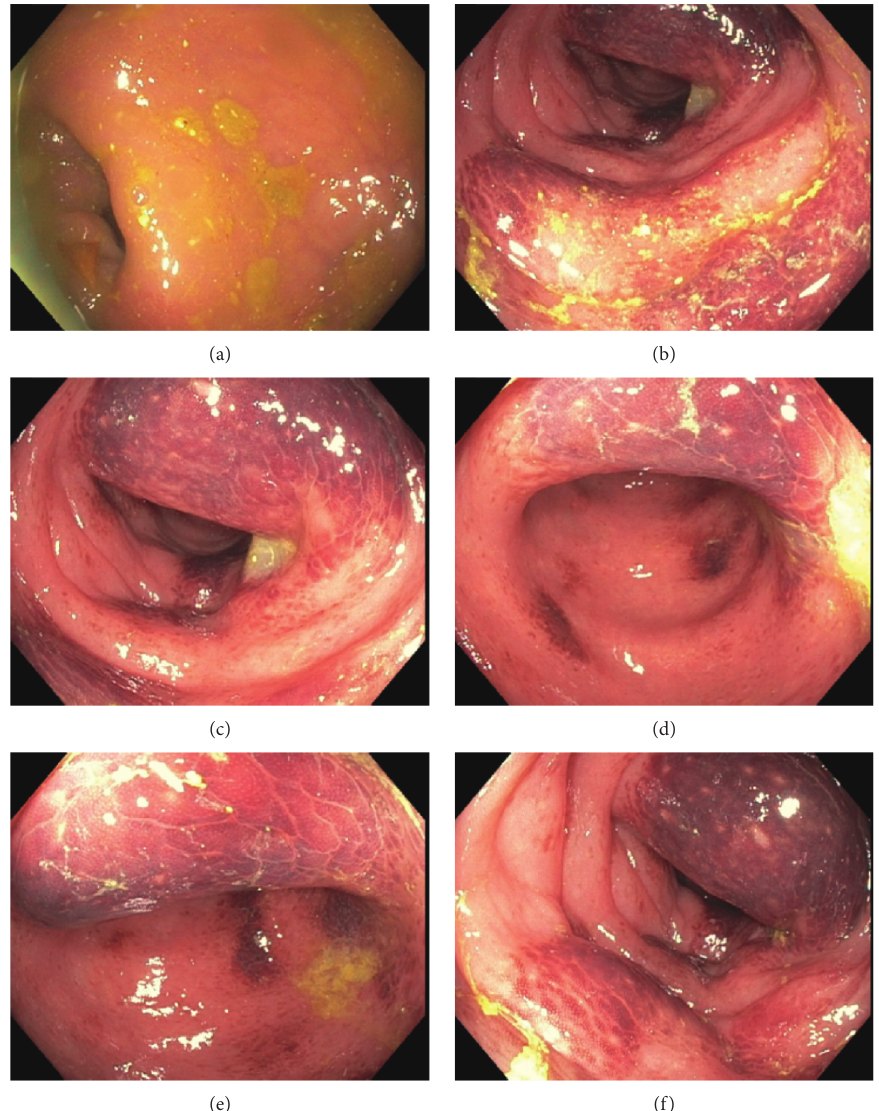
Figure 2: Endoscopic images up to midsigmoid demonstrating patchy, dusky areas of mucosa with submucosal swelling and erythema but no frank ulcerations.